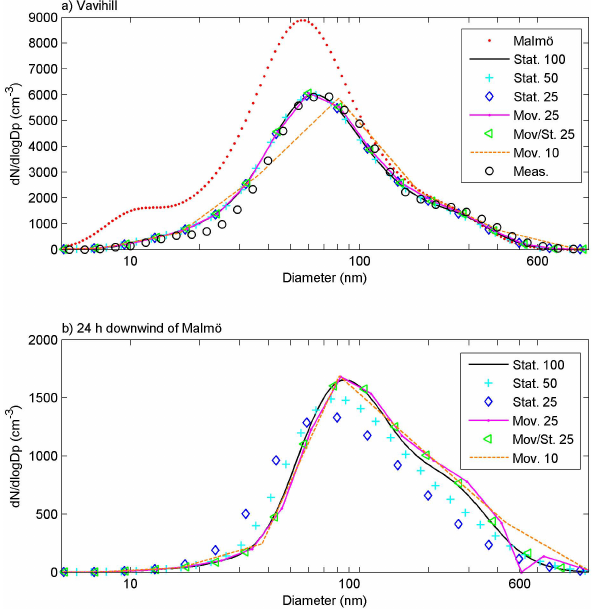
Fig. 4. Modeled particle number size distributions in the center of the urban plume at Vavihill (a) and 24h downwind of Malm¨o (b) , using different size structure methods. The results are from the sim- ulations with the full-stationary structure using 100, 50 or 25 size bins, moving-center structure with 25 or 10 size bins and a com- bination of the moving-center method and full-stationary method using 25 size bins (Mov/St). Panel (a) also displays the modeled (fitted) particle number size distribution at the measurement sta- tion in Malm¨o and the measured particle number size distribution at